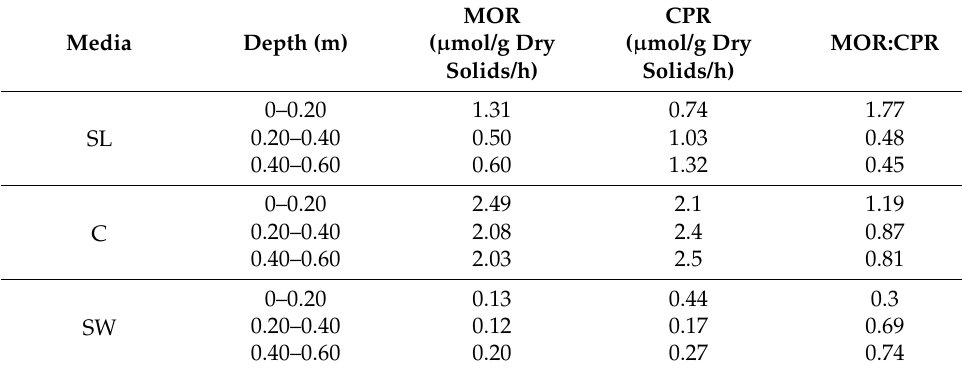
Table 4. Methanotrophic activity in the bio-cover materials.